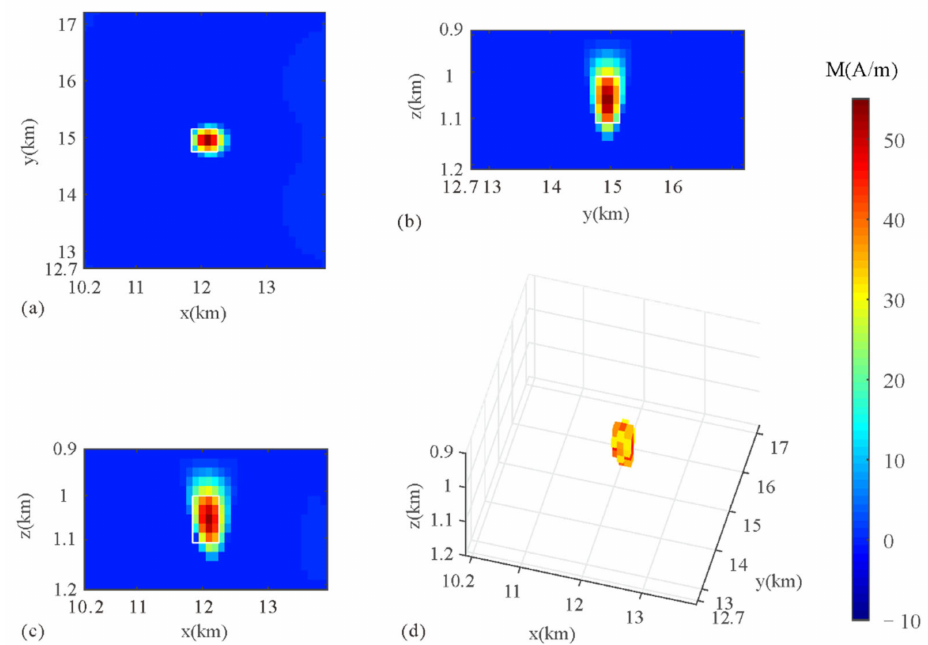
Figure 7. Inversion results of extracted magnetite-caused anomalies (the white box represents the actual scope of the magnetite body): ( a ) a horizontal slice at z = 1050 m, ( b ) a vertical slice at x = 12.1 km, ( c ) a vertical slice at y = 14.8 km, and ( d ) a volume-rendered image of the 3D model with magnetization less than 30 A/m being